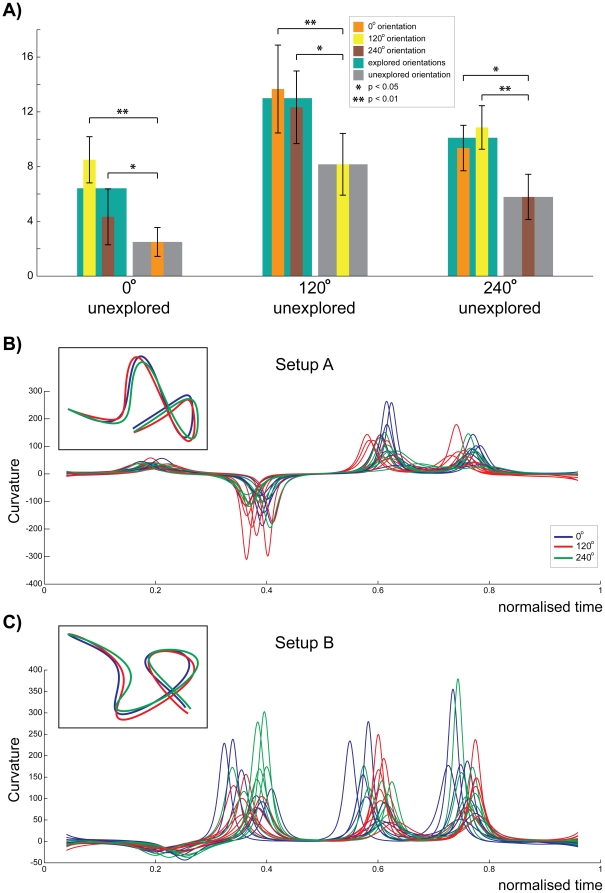
Orientation effect.(A) Explored orientations (turquoise bar) showed consistently larger effect than the unexplored orientation (grey bar), irrespective of the specific unexplored orientation. The mean trajectories of a representative subject during SOL1 in the different orientations (inset of B and C) and mean curvature of all the subjects (three color traces of B, C) show minor but significant (setup A: pSOL1<1e-16; setup B: pSOL1<1e-12) differences in the curvature profiles across orientations. Note that the curvature signature (and hence the solution classification) was maintained. Similar effects were also observed for SOL2 in both setups (setup A:pSOL2<1e-5; setup B:pSOL2<1e-16)